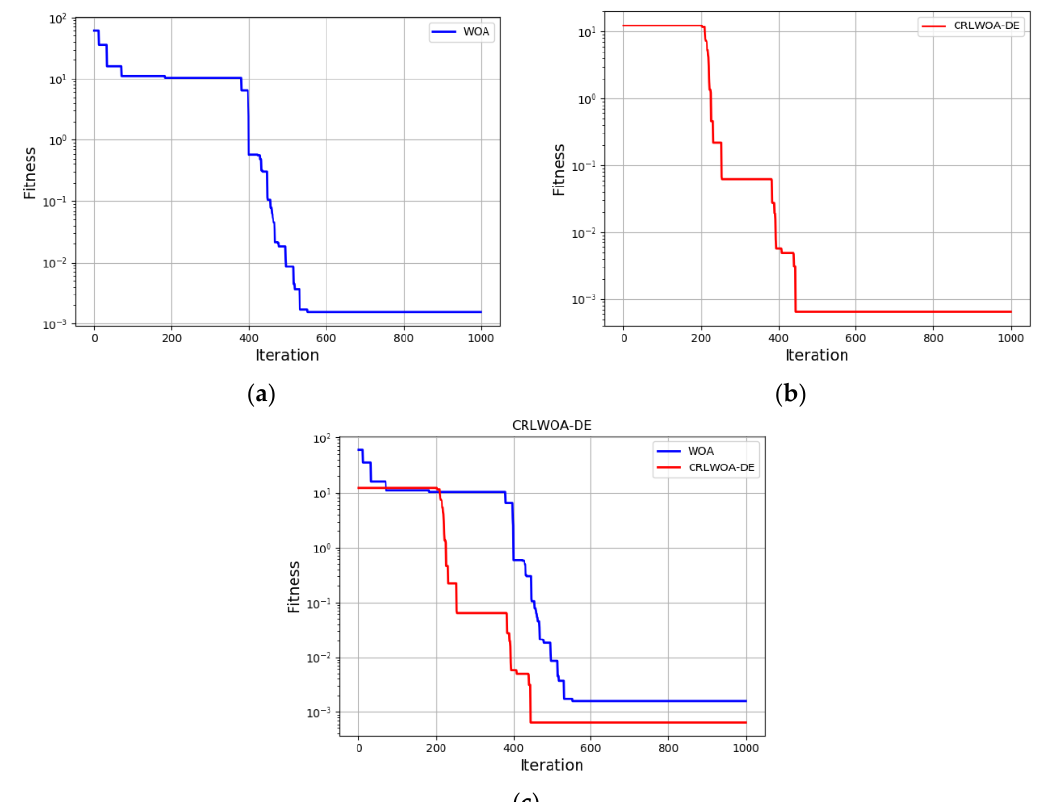
Figure 10. ( a ) WOA optimization curve; ( b ) CRLWOA-DE optimization curve; ( c ) convergence curves of WOA and CRLWOA-DE. Table 2. Comparison of optimization results between whale optimization algorithm and improved whale optimization algorithm.